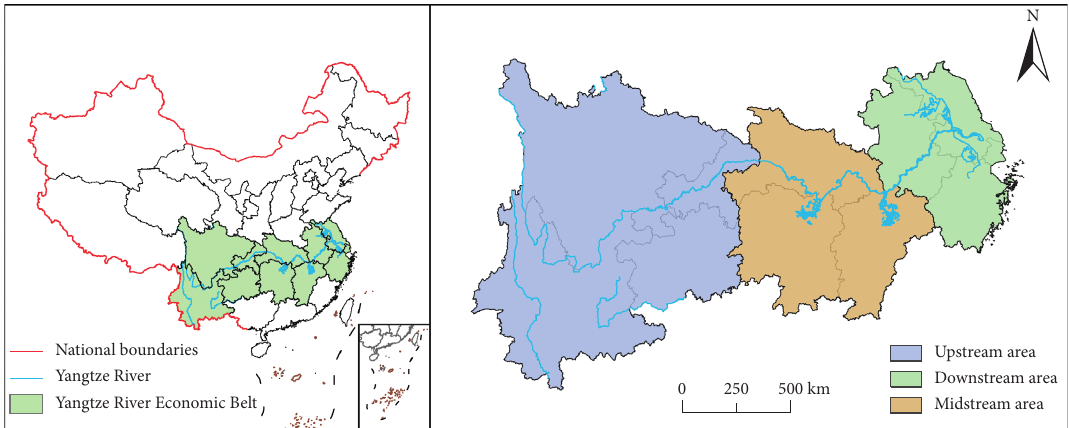
Figure 2: Location of the Yangtze River Economic Belt in